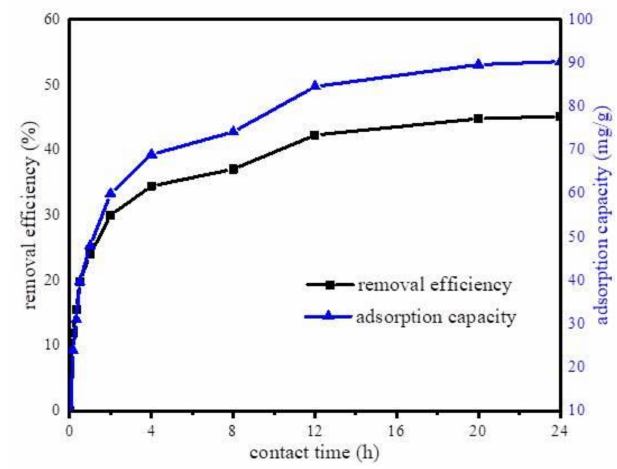
Figure 8. E ff ect of the adsorption time on the uptake of diclofenac sodium (DCF) onto